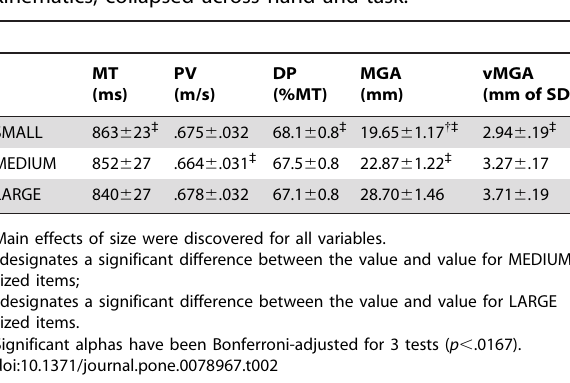
Table 2. Means and standard errors of reach and grasp kinematics, collapsed across hand and task.